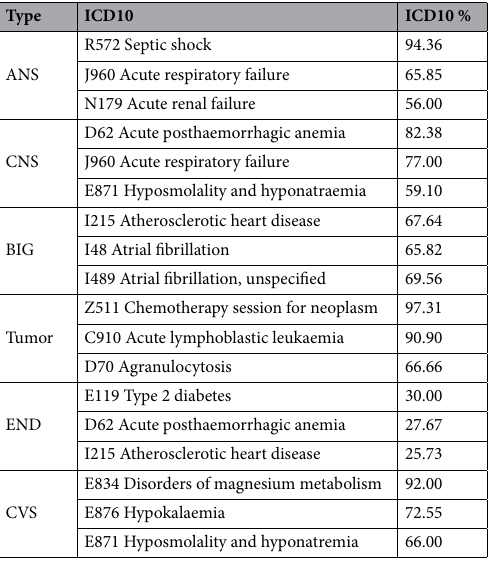
Table 17. The three highest numbers of ICD10 percent for each HAD type in IPD data set.